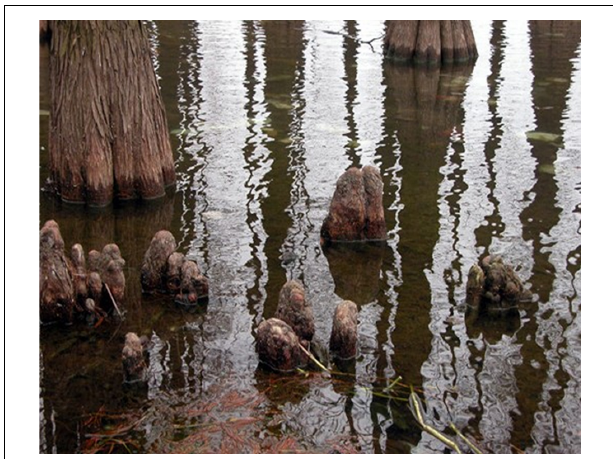
FIGURE 8 | Knee roots of Taxodium ascendens in the wetland.